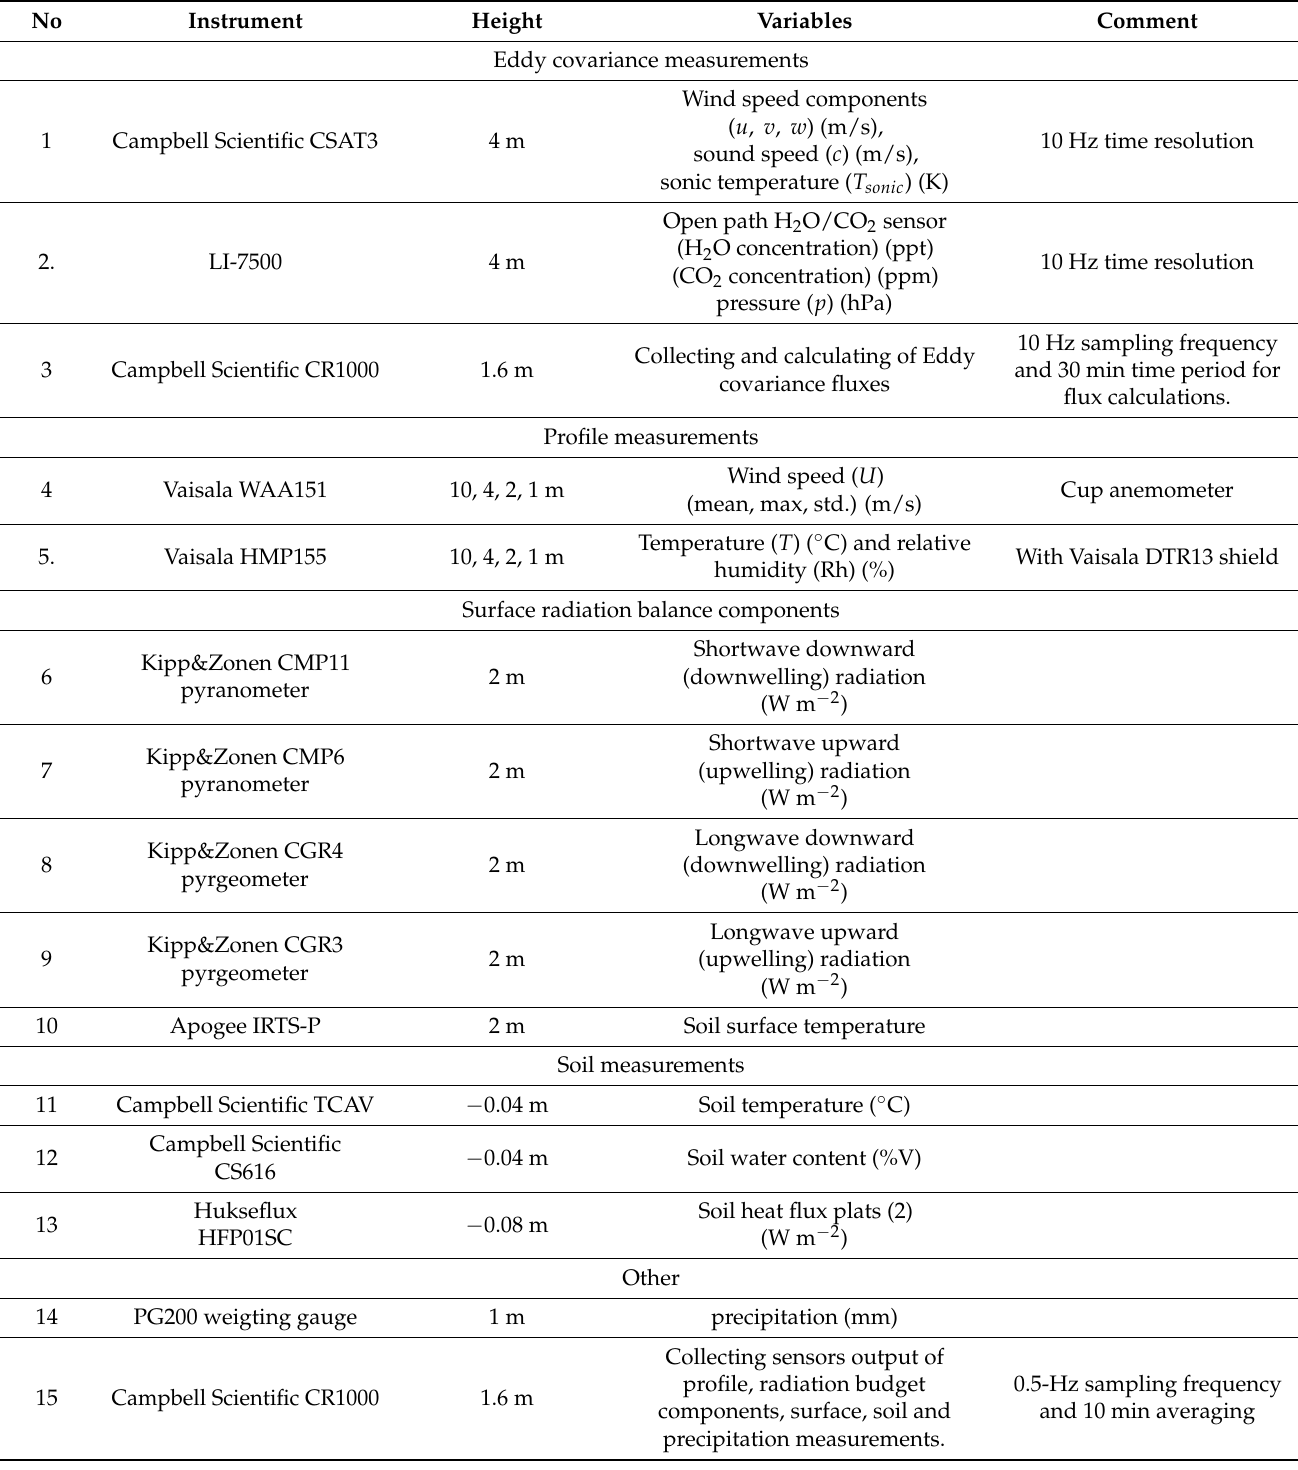
Table 2. Instrumentation used on the micrometeorological measurements in Agrometeorological Observatory Debrecen (Figure 1) from